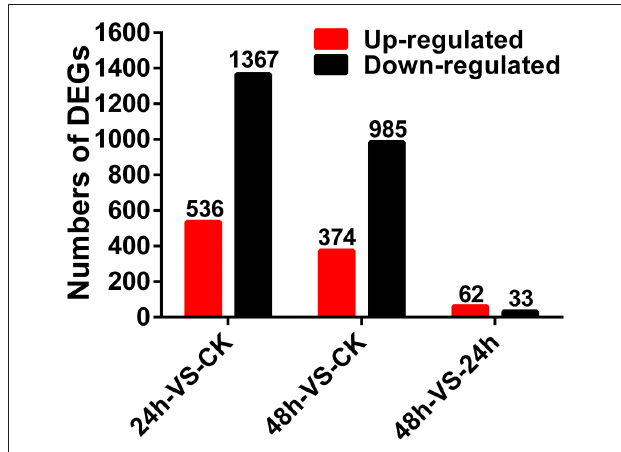
FIGURE 1 | Differentially expressed genes of A. thaliana during early infection by P.